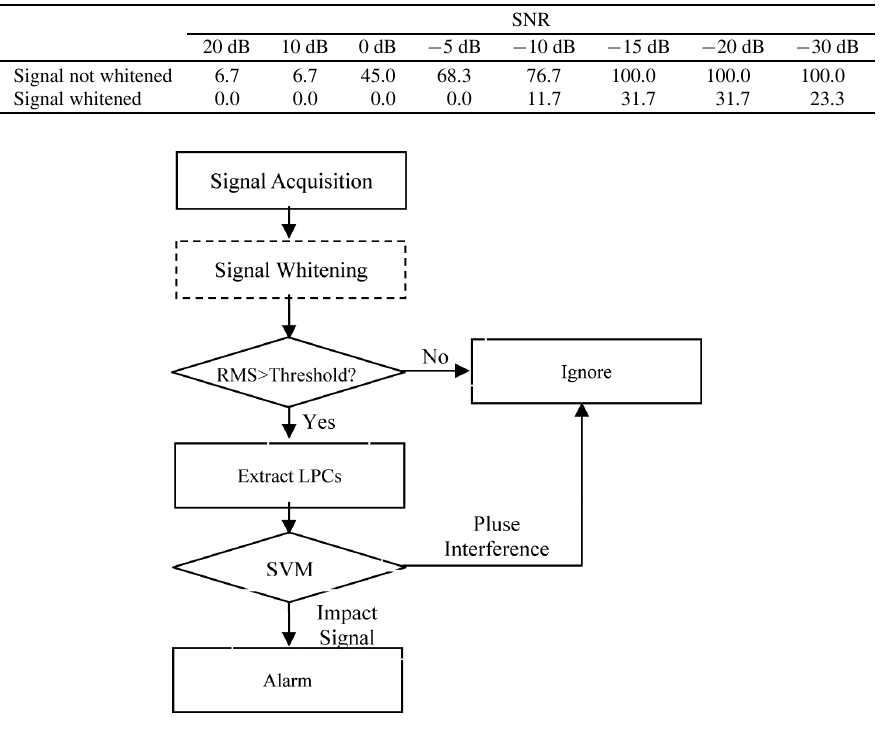
Table 1 The missed detection rate(%) when the LPCs is